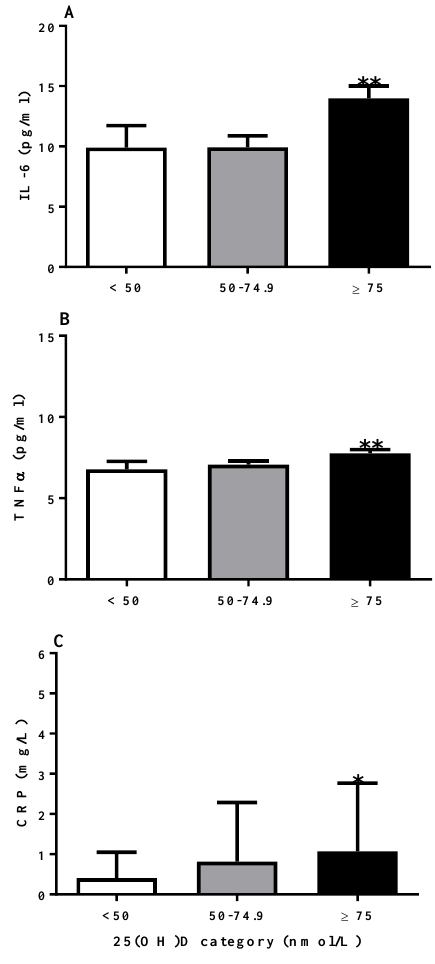
Figure 1. IL-6 ( A ) and TNFα ( B ) and CRP ( C ) comparison between vitamin D categories (<50 nmol/L: n = 52, 50–74.9 nmol/L: n = 189, ≥75 nmol/L: n = 216). Data are mean ± SD. * Significantly greater than <50 nmol/L category, ** significantly greater than <50 nmol/L category and 50–74.9 nmol/L categories ( p < 0.05) using mixed model ANOVA, adjusted for season, age, sex, and BMI z -score. From a normative dataset of healthy girls 13–17 years [29], mean IL-6 and TNFα concentrations were 16.6 ± 40.8 pg/mL and 10.1 ± 21.8 pg/mL respectively. Mean CRP from a normative dataset of preschool age children was 1.9 ± 4.0 mg/L [30].